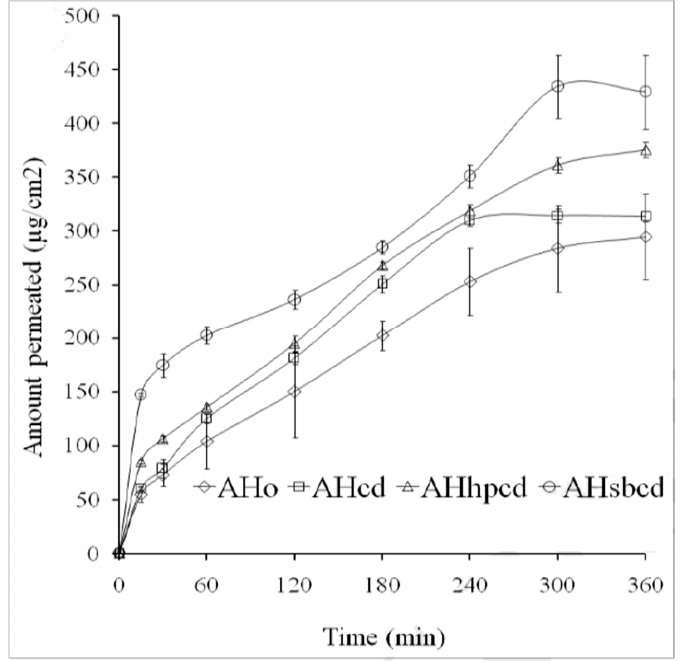
Figure 7. Ex vivo permeation study of amlodipine–CD containing HPMC films on excised sheep Figure7. Exvivopermeationstudyofamlodipine–CDcontainingHPMCfilmsonexcisedsheepcornea. AHo: films without CD, AHcd: with β –CD, AHhpcd: With HPBCD, AHsbcd: With sulfobuthylaether- β -CD